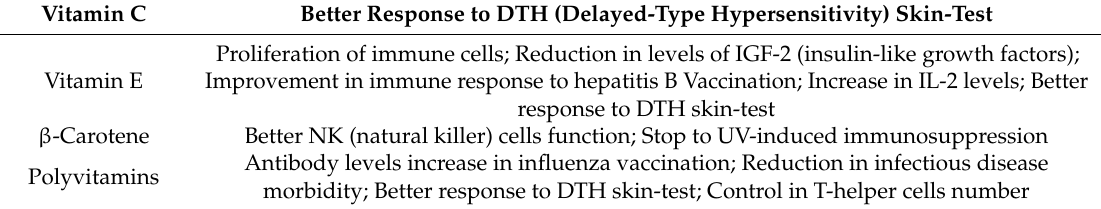
Table 2. Micronutrients supplementation effects on immune system during